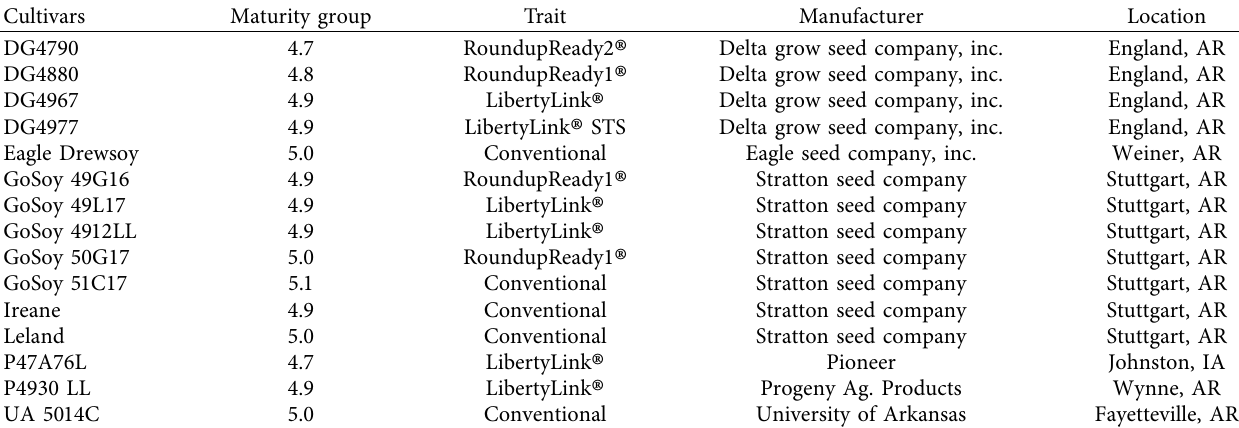
Table 1: Soybean cultivars, maturity groups, and traits as well as manufacturer and address.